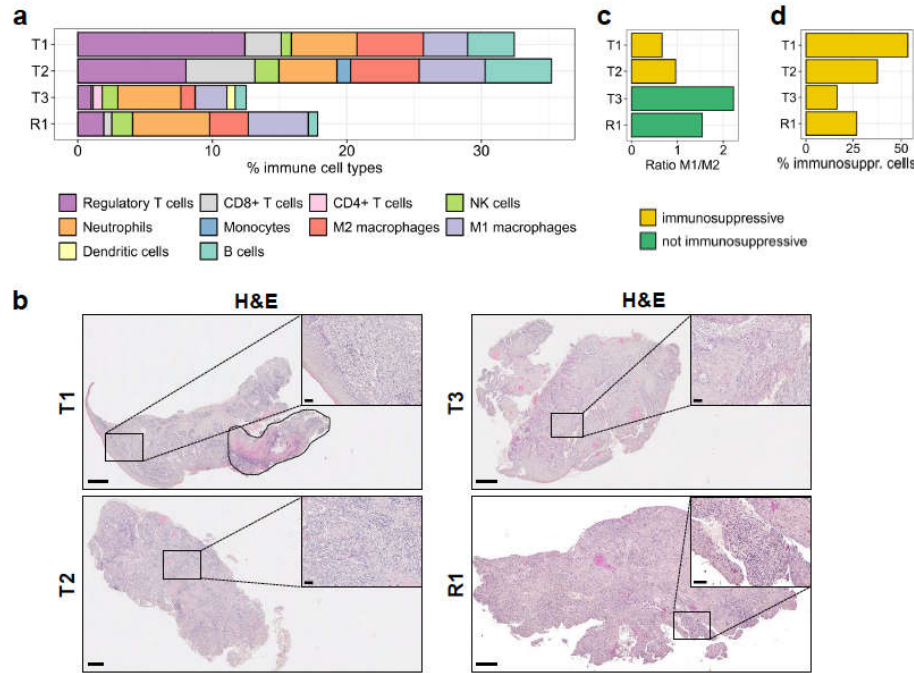
Figure 4. Immune cell profile of the tumour samples. ( a ) The absolute fractions of immune cell types infiltrated in the primary and in the recurrent tumours, as determined by quanTIseq from RNA-seq reads, are shown. ( b ) Histological analysis by H&E staining. Areas with high immune cell infiltration in the tumour are shown in the insets. T1 is a mixture of squamous cell carcinoma and carcinoma in situ, which is marked by a dashed line (top left). Scale bars: 500 µ m for full-size images and 50 µ m for insets. ( c ) The ratio of M1/M2 macrophage fractions in the samples, derived from quanTIseq deconvolution. ( d ) Immunosuppressive cells (regulatory T cells, M2 macrophages) as a percentage of the total fraction of infiltrated immune